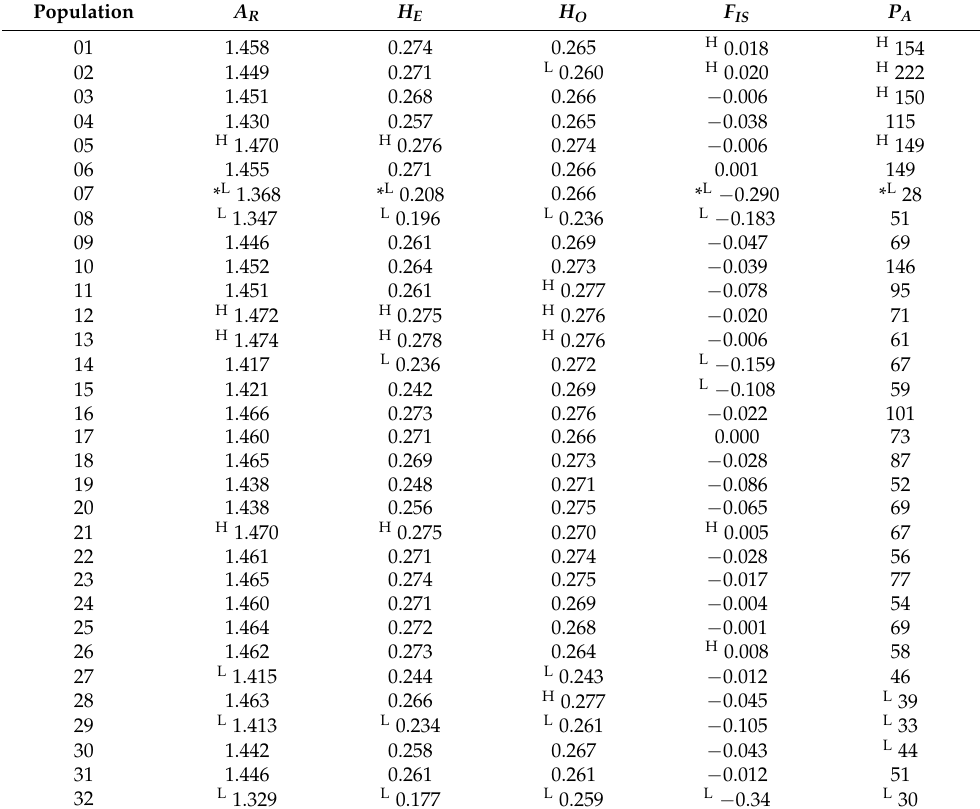
Table 2. Population genetic diversity estimates for Ficus coronata collected from 32 NSW locations, showing population allelic richness ( A R ), expected ( H E ) and observed ( H O ) heterozygosity, inbreeding ( F IS ), and private alleles ( P A ). Prefix of L shows the 4 lowest results for each variable and H the 4 highest. See Figure 7 for mapped highs and lows and Table 1 for site population details of populations. * Possible biased results with only 2 individuals collected, this site has been excluded from the maps in Figure 7. Population A